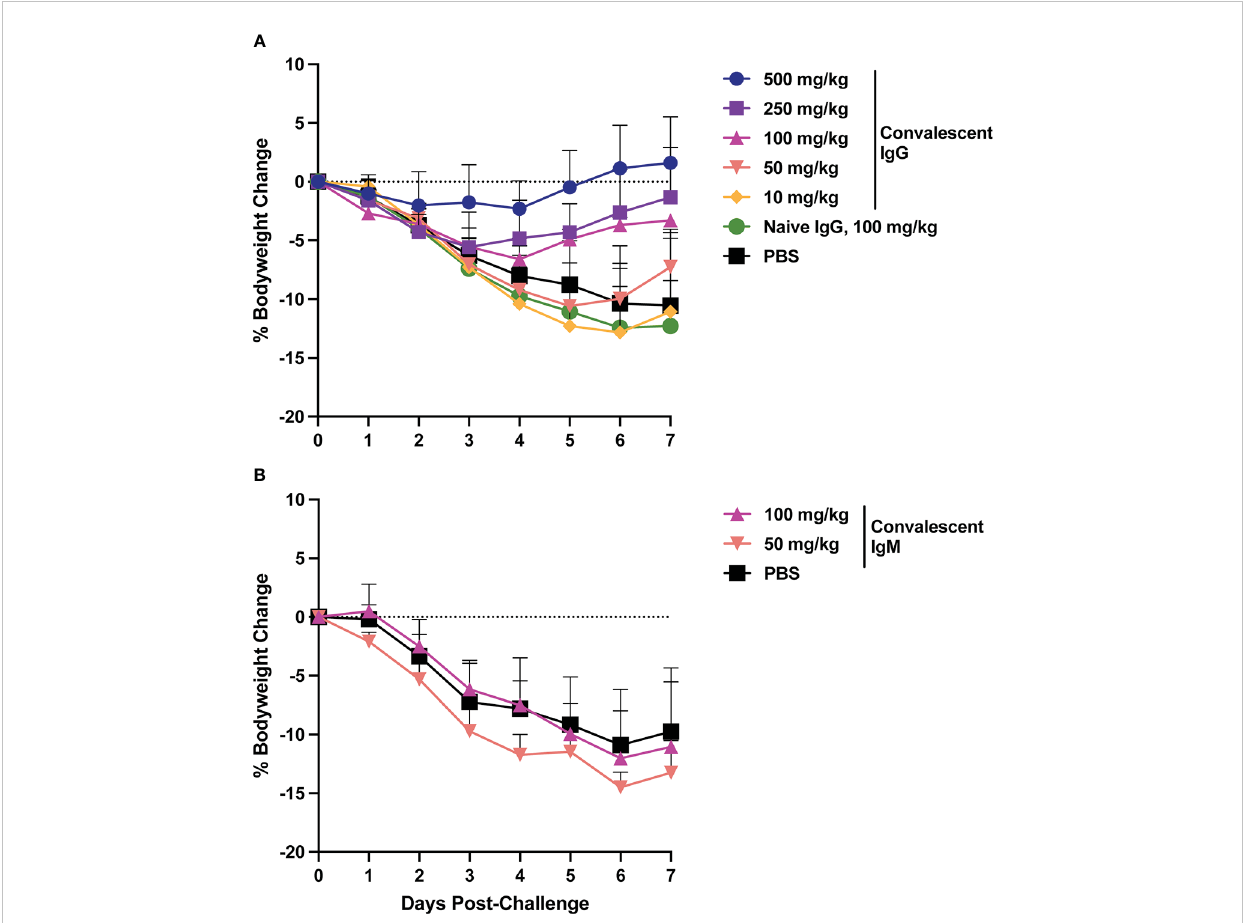
FIGURE 2 Body weight changes following SARS-CoV-2 challenge. Hamster weight was recorded daily in hamsters from the time of viral challenge until necropsy. Graphs show the mean body weight change from time of challenge for each group in the animals that received passively transferred IgG (A) or IgM (B) . Error bars indicate standard